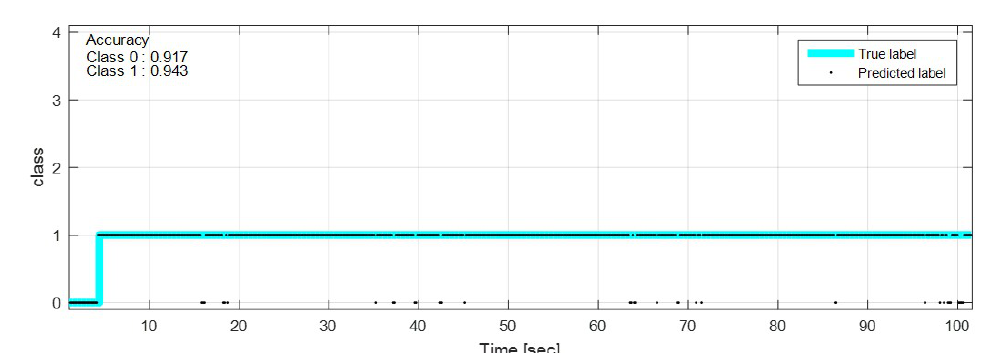
Figure 13. Prediction result on sinusoidal road, 20 km/h.